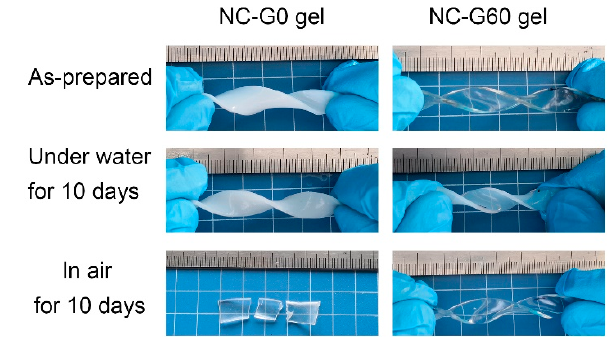
Figure 7. Illustration of NC-G gels at different conditions.